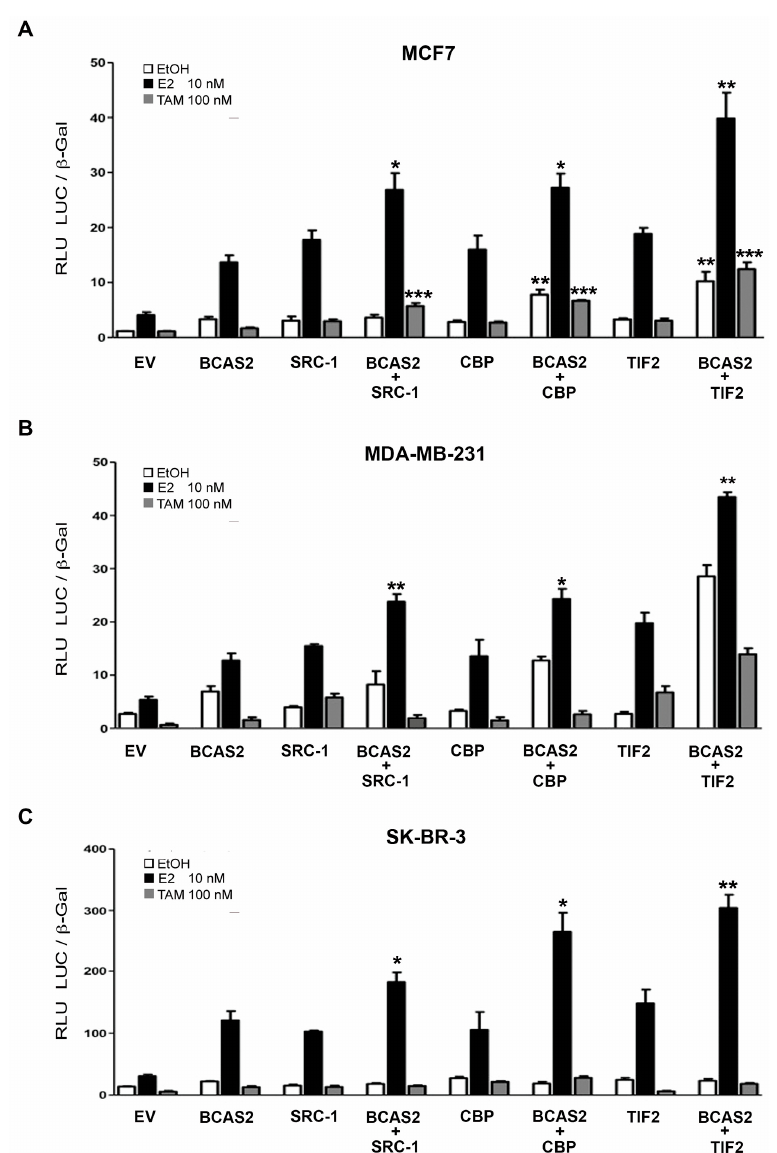
Figure 4. BCAS2 acts together with AF-2 coactivators to increase ER α activity. ( A ) Luciferase assays were carried out with pcDNA-BCAS2 or empty vector (EV), transfected with and without coactivators SRC-1, CBP or TIF2 and treated in the absence (EtOH) or presence of 10 nM of E2 or 100 nM of TAM in MCF7 cells. Similar assays were carried out in MDA-MB-231 ( B ) and SK-BR-3 ( C ) cells with the addition of transfected pSG5-ER Statistical analysis was carried out using one-way ANOVA with Bonferroni posttest; * p < 0.01, ** p < 0.005, *** p < 0.001 .